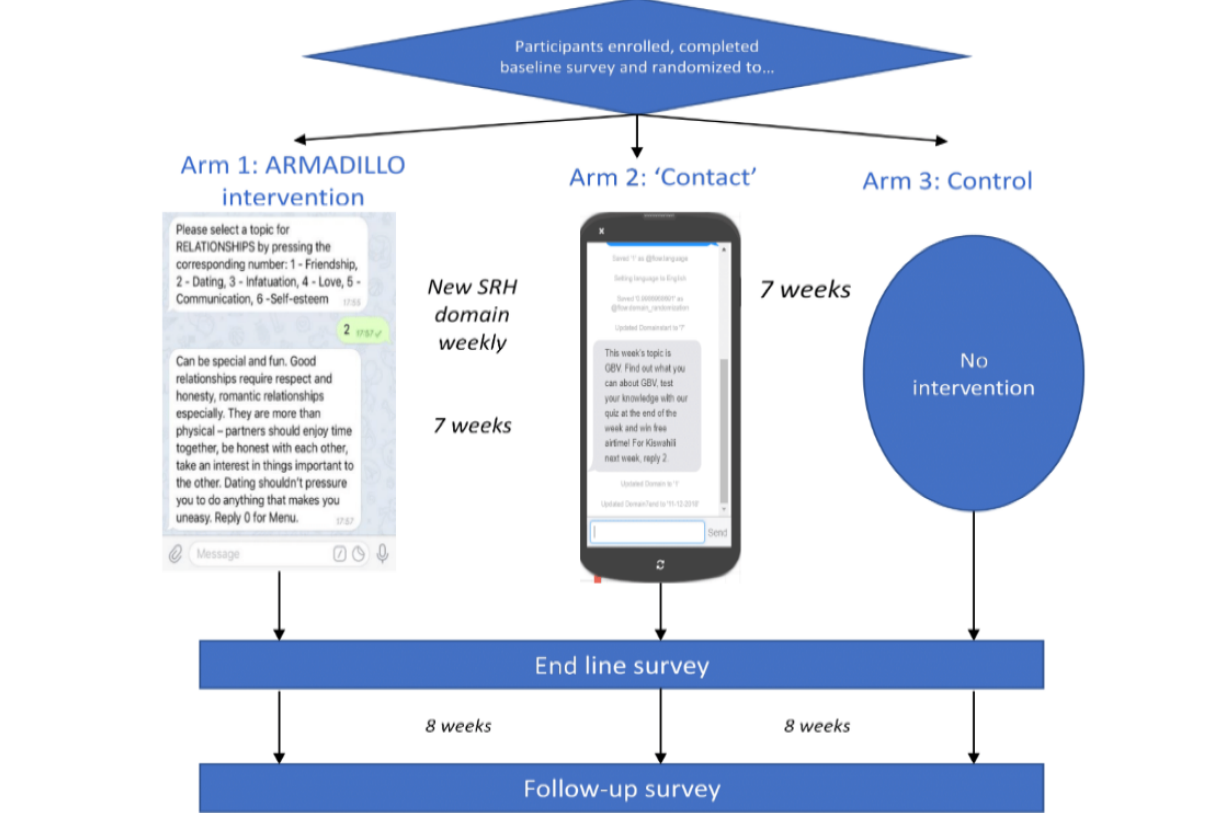
Figure 1. Adolescent/Youth Reproductive Mobile Access and Delivery Initiatives for Love and Life Outcome trial diagram. ARMADILLO: Adolescent/Youth Reproductive Mobile Access and Delivery Initiatives for Love and Life Outcome; SRH: sexual and reproductive